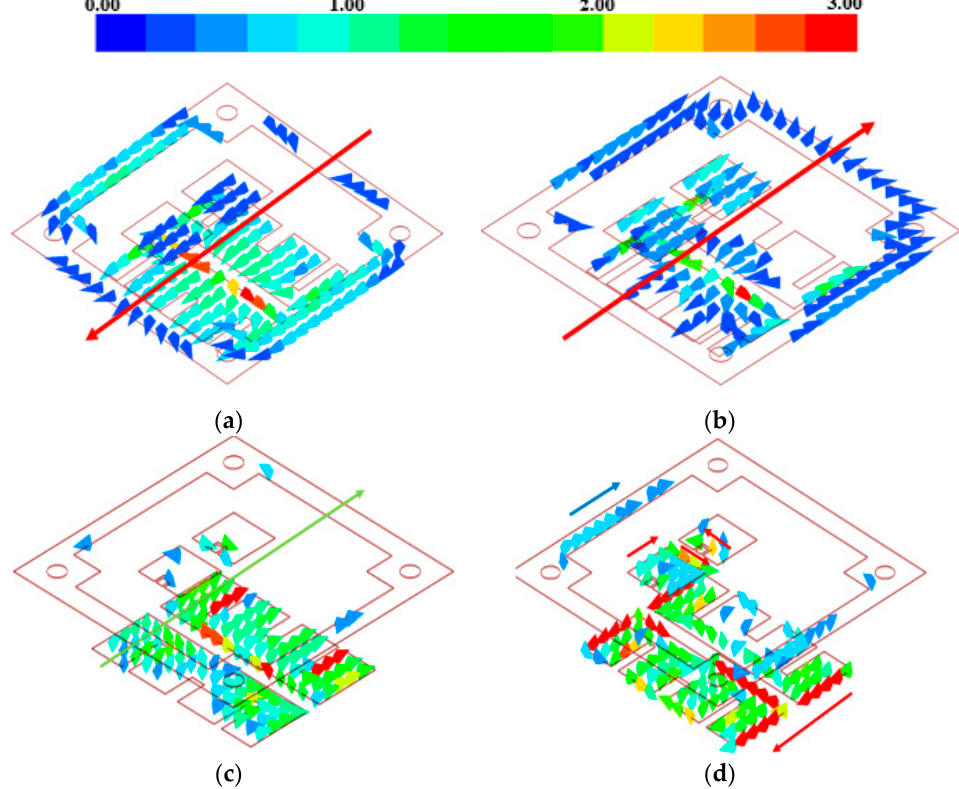
Figure 8. Current distribution on the antenna element at ( a ) 13 GHz, ( b ) 16 GHz, ( c ) 17.5 GHz, and ( d ) 18 GHz.